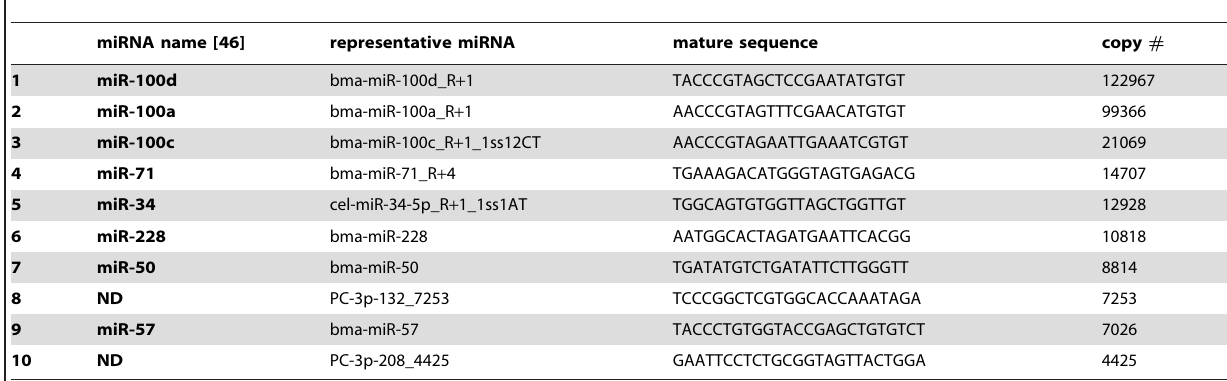
Table 2. Ten most abundant circulating nematode miRNAs in dog